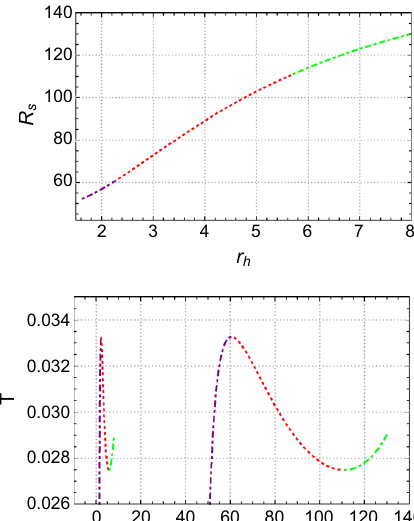
Fig. 3 The upper diagram shows the relation between the shadow radius and the event horizon for the Kerr-AdS black hole. The bot- tom diagram shows the temperature in terms of the event horizon (left curve) and the shadow radius (right curve) for the black hole, respec- tively. We set r O = 100 , J = 1 , θ O = π/ 2 , (cid:13) = − 0 . 03. The purple, red and green curves in the top diagram correspond to the curves with the same colours in the bottom diagram